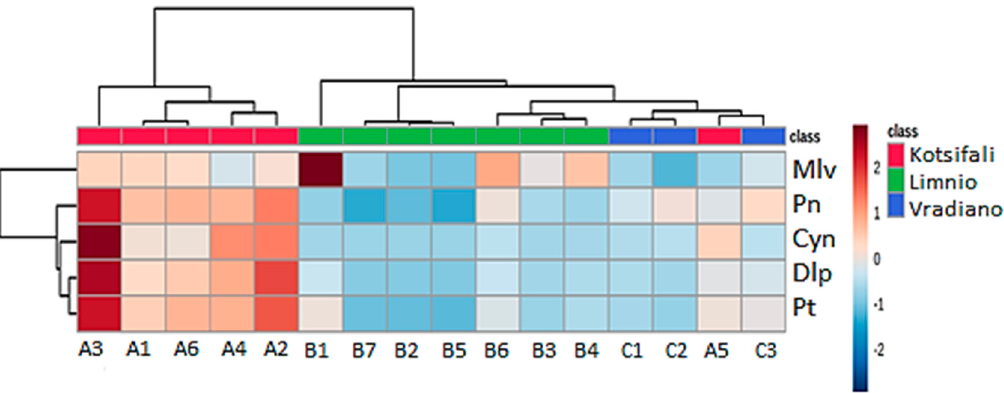
Figure 5. Hierarchical cluster analysis (HCA) of 16 samples of red grapes based on anthocyanins (Mlv; Pn; Cyn; Dlp; Pt).